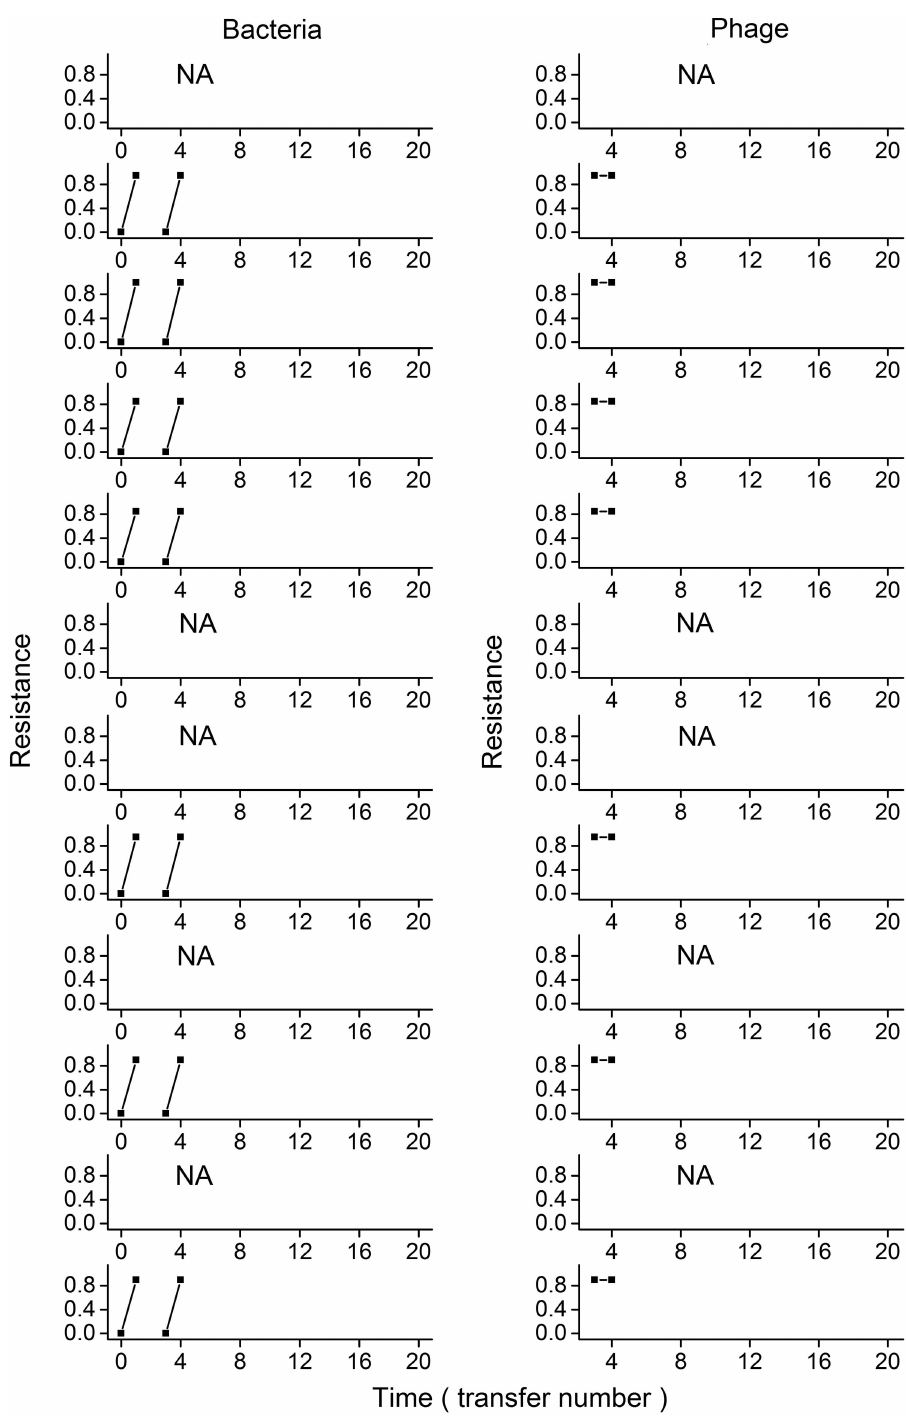
Fig 3. Change in bacterial resistance and phage infection in low-resource microcosms. Each row represents one individualmicrocosm. In each panel of the left column, each line shows the proportionof bacteriafrom four transfers in the past, contemporary transfer and four transfers in the future (from left to right) that are resistant to phagesfrom a given transfer. A positive slope indicatesan increasein bacterial resistanceover time. In each panel of the right column, each line shows the proportionof bacteriafrom a given transfer that are resistant to phages from four transfers in the past, contemporary transfer and four transfers in the future (from left to right). A negativeslope indicatesan increasein phage infection over